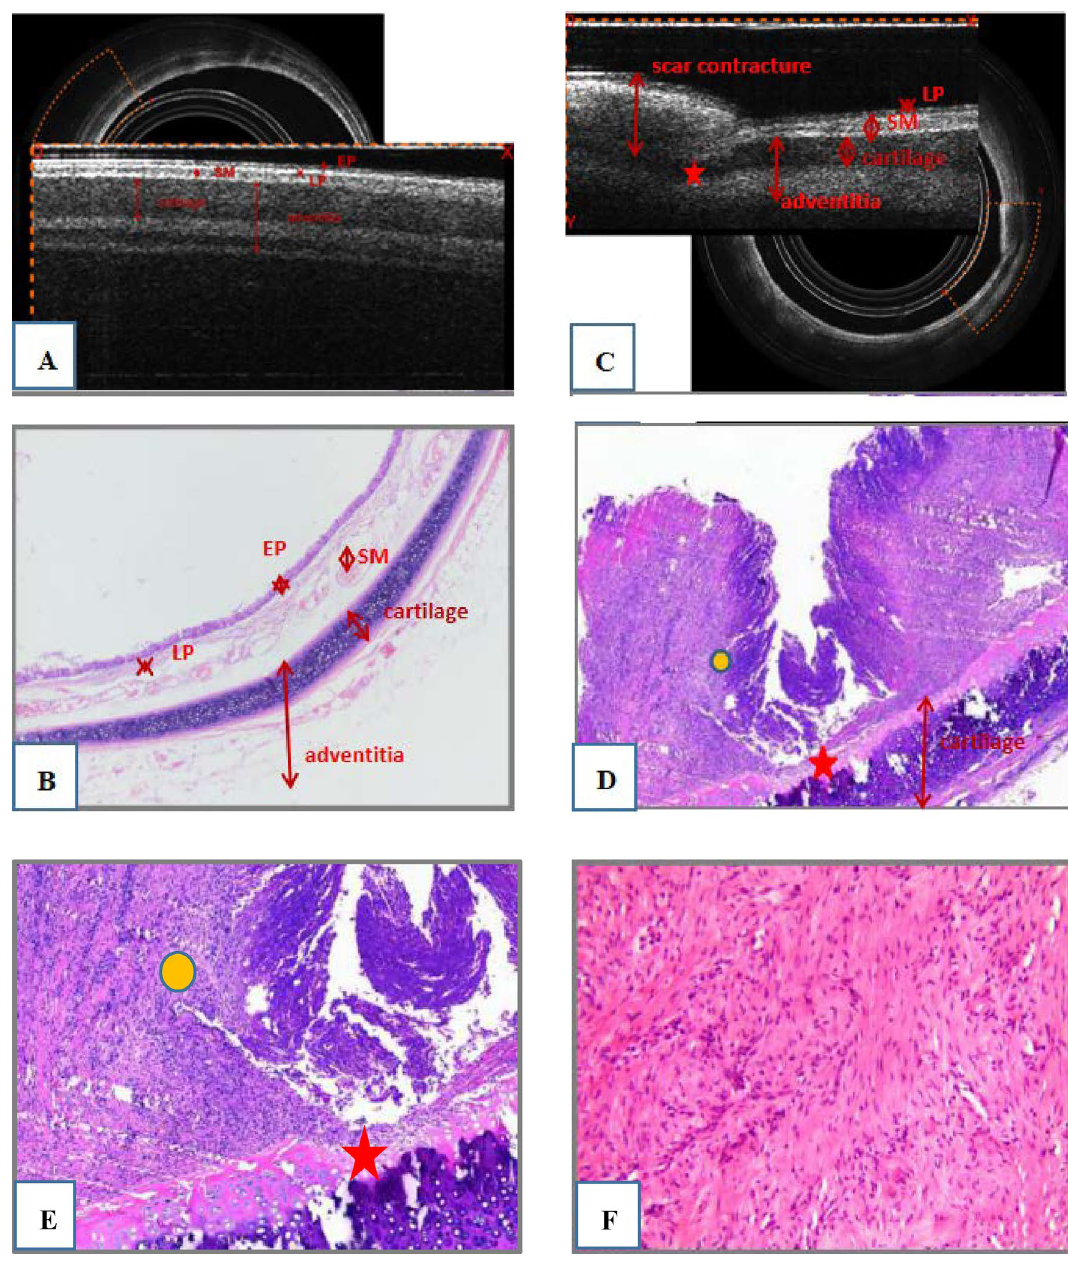
Figure 5. ( A ) EB-OCT images of rabbits without airway stenosis, ( B ) airway histological characteristics of rabbits without airway stenosis (HE; original magnification ×40). ( C ) EB-OCT images of rabbits with airway stenosis, ( D,E ) airway histologic characteristics of rabbits with airway stenosis. D (HE; original magnification ×100) and ( E ) (HE; original magnification ×200) airway stenosis showing ciliated columnar epithelial necrosis and shedding, a small amount of residual epithelial tissue, the submucosal fibrous tissue proliferating and protruding into the tracheal lumen, inflammatory cell infiltration in the interstitium (yellow circle), the smooth muscle of the tube wall is broken and atrophied, and the focal cartilage is damaged (red pentagram); ( F ) fibroblastic proliferation EB-OCT endobronchial optical coherence tomography, HE hematoxylin–eosin, EP epithelial, LP laminae propria, SM submucosa showed strong white signal, the smooth muscle layer showed gray signal intensity, and the cartilage layer showed weak black signal. The EB-OCT images of rabbits with tracheal stenosis formation showed obvi- ous narrowing of the lumen, thickening of the mucosa and submucosa (strong signal reflection band), some layers projecting inward, and discontinuity of the cartilage layer (low signal reflection band). In group B, the tracheal wall of the 5 rabbits without tracheal stenosis was cut and sutured along the smooth muscle and elastic fibers between the cricoid cartilage, but no stenosis was found by bronchoscopy, HRCT, EB-OCT and tracheal anatomy. It can be seen that simple tracheotomy and incision suture do not cause stenosis of the rabbit tracheal.